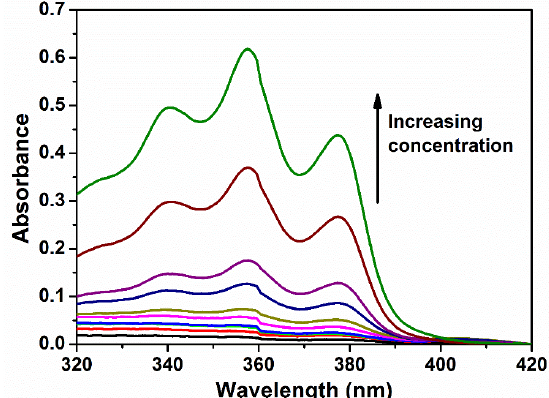
Figure 5. UV-Vis spectra of DPH with increasing concentration of copolymer P2 in water at 25 °C. DPH concentrations were fixed at 0.6 mM, while copolymer concentrations were varied between 1.0 and 0.002 wt %. The increase the absorbance of DPH at 378 nm shows the formation of a hydrophobic environment from the micellisation process.